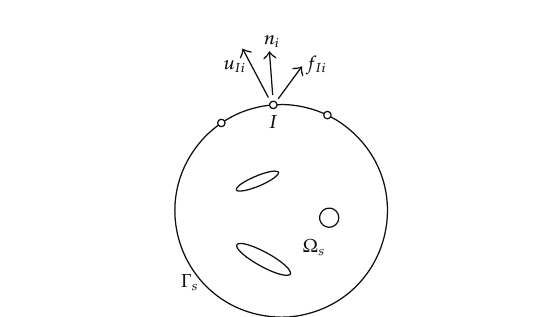
Figure 3: The normal, the nodal displacement, and the nodal force on the boundary of the subscale model.